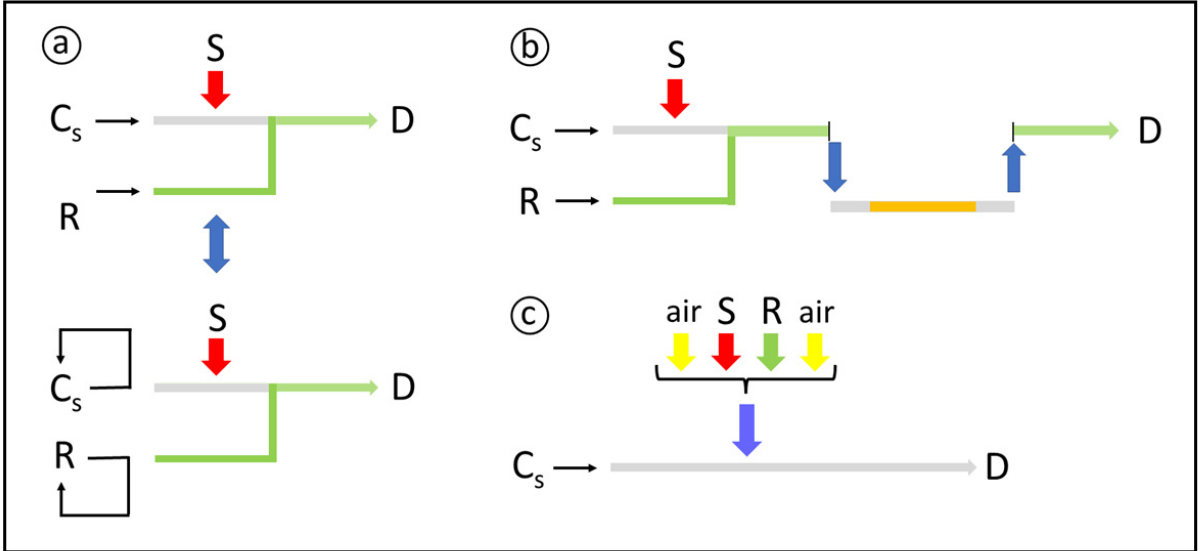
Figure 2. Flow manifolds related to strategies for increasing sample residence time without significantly incrementing sample dispersion. a —flow stopping, b —zone trapping, and c —monosegmented flow analysis. S: sample; R: reagent; C S : sample carrier stream; D: detection; Large arrows: time ‐ based, loop ‐ based, hydrodynamical or syringe insertions; Small arrows: flow directions. For details, see text.